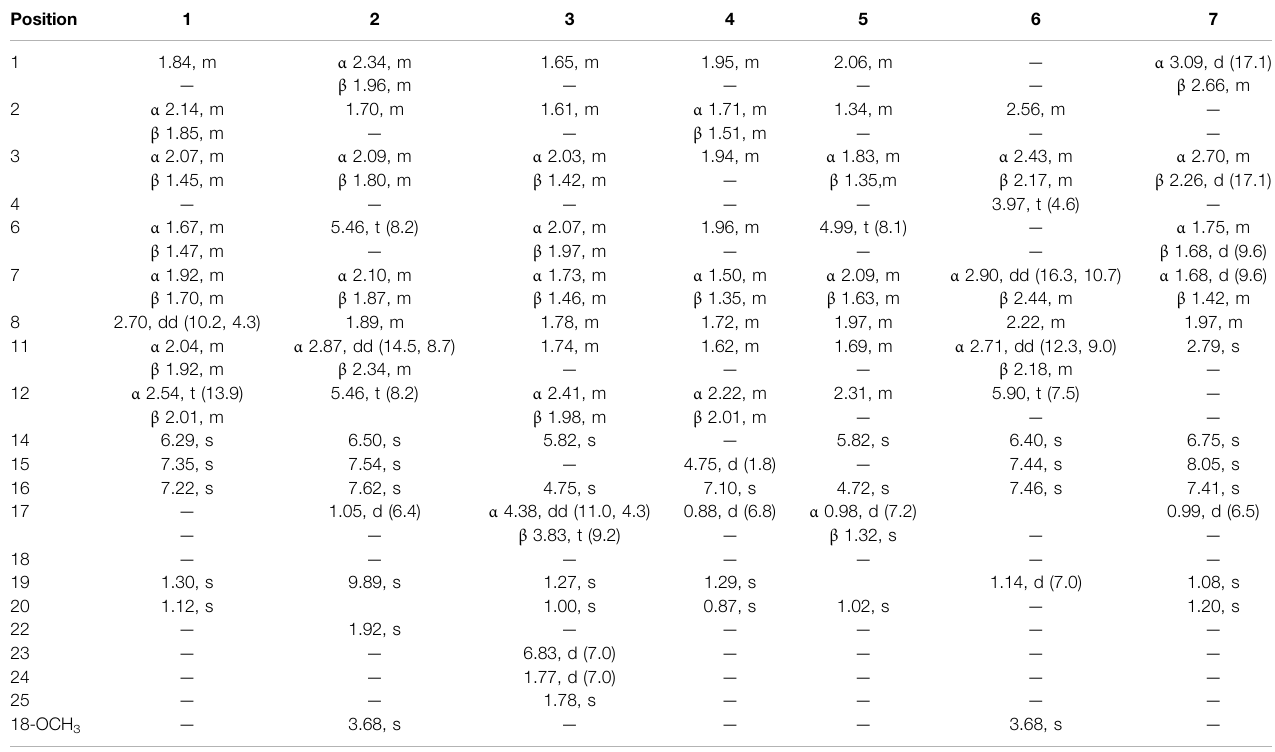
a All measured in CDCl3 at 400